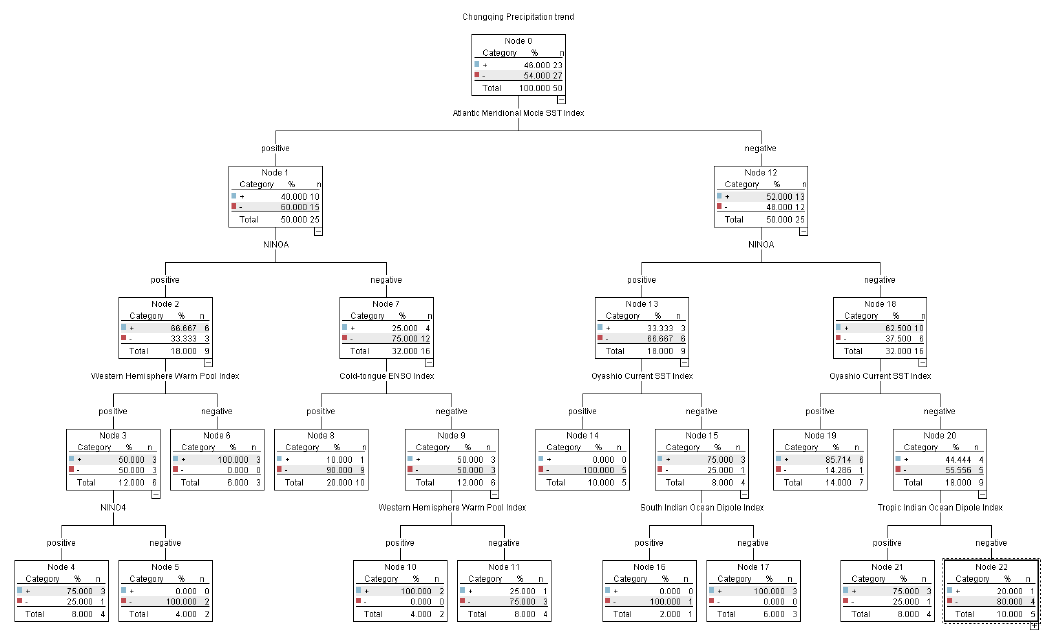
Figure 3. Relationship between precipitation trend in summer and SST index in pre-winter based on the CART algorithm in Chongqing.